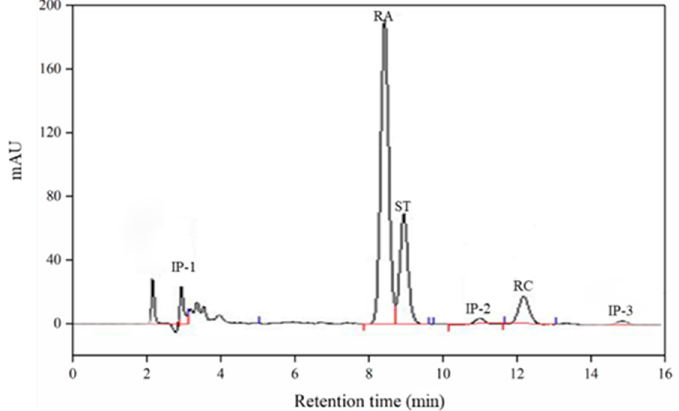
Figure 1. HPLC chromatogram of crude stevia at 210 nm wavelengths.